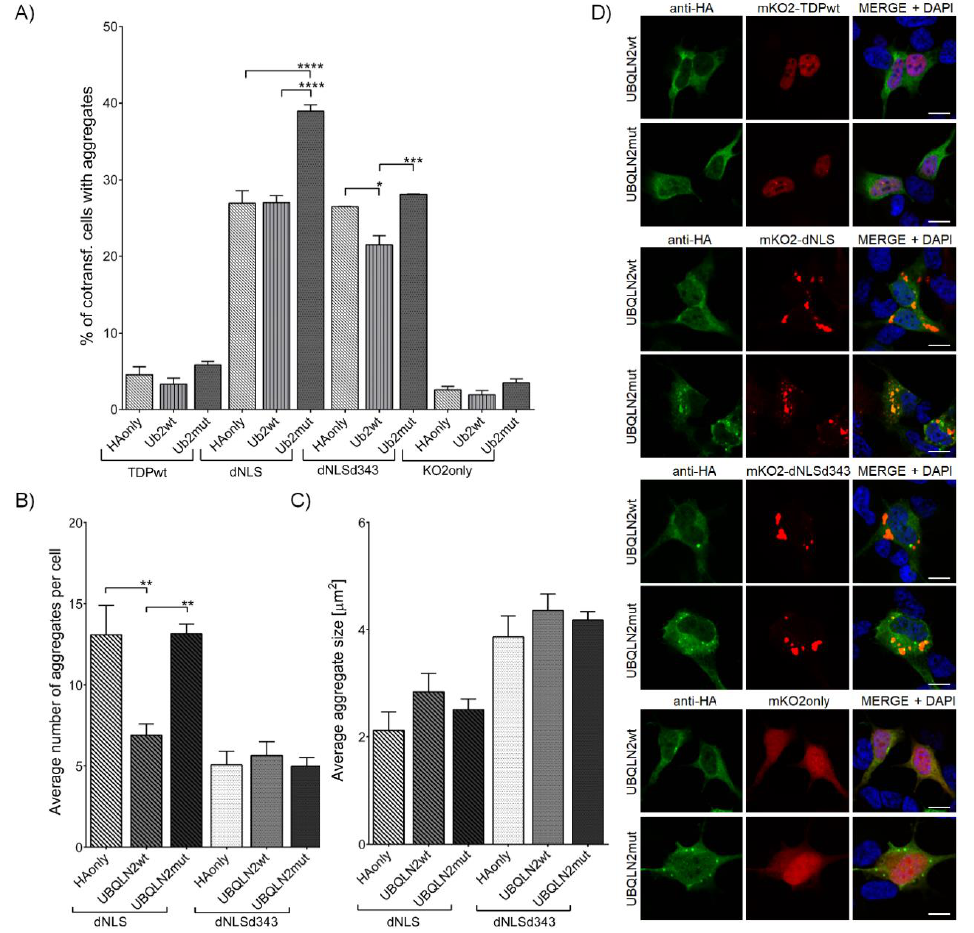
Figure 5. SH-SY5Y cells co-transfected with mKO2 constructs and wt or mut UBQLN2. ( A ) Quantification of co-transfected cells harboring aggregates. ( B ) Average number of aggregates in an individual cell. ( C ) Average aggregate size. ( D ) SH-SY5Y cells co-transfected with mKO2 constructs and wt or mut UBQLN2. Probed for HA-tag and counterstained with DAPI. Scale bars: 10 µm.